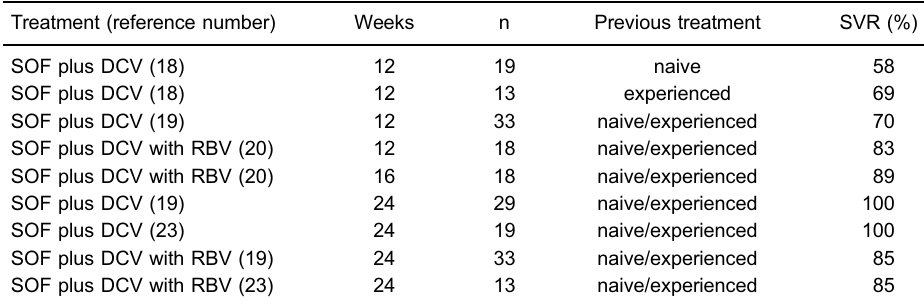
Table 4. Summary of sustained virological response (SVR) rates in cirrhotic patients with hepatitis C virus (HCV) genotype 3 infection treated with sofosbuvir (SOF) plus daclatasvir (DCV) with or without ribavirin